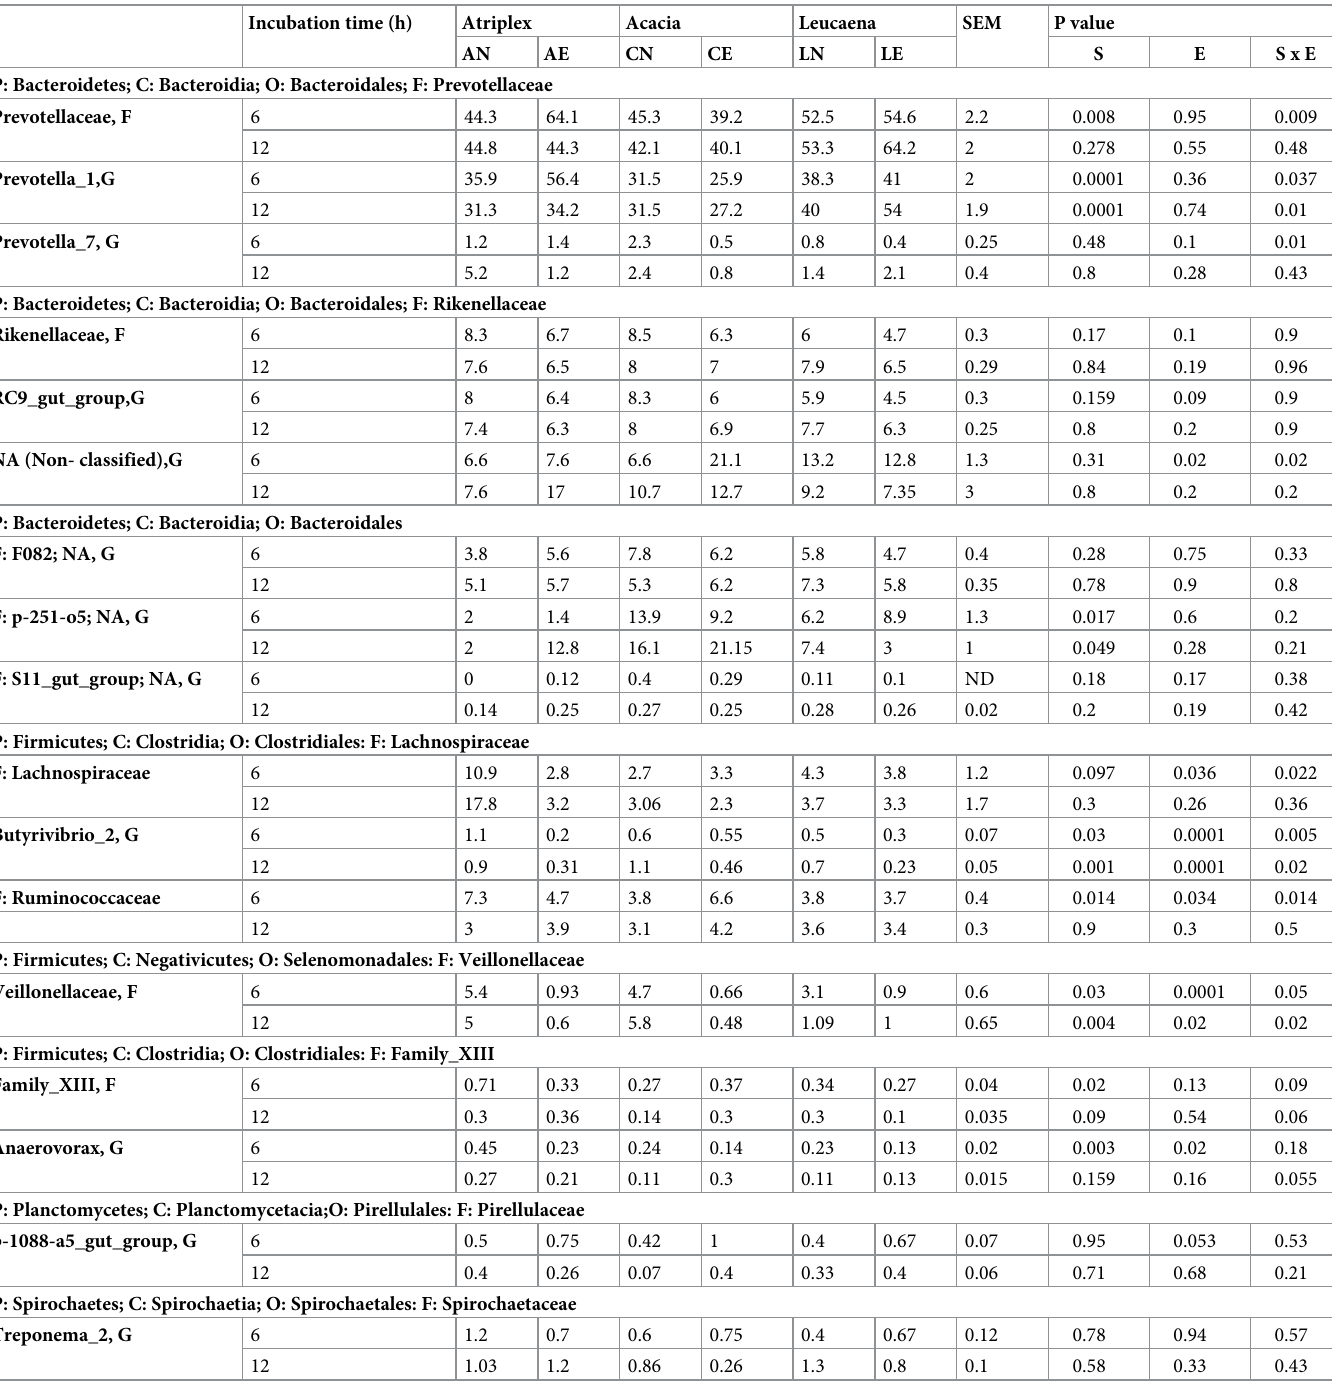
Table 5. The of relative abundance (%) of dominant bacterial families and genera colonizing extracted and nonextracted plants at 6 and 12 hours. Incubation time (h) Atriplex